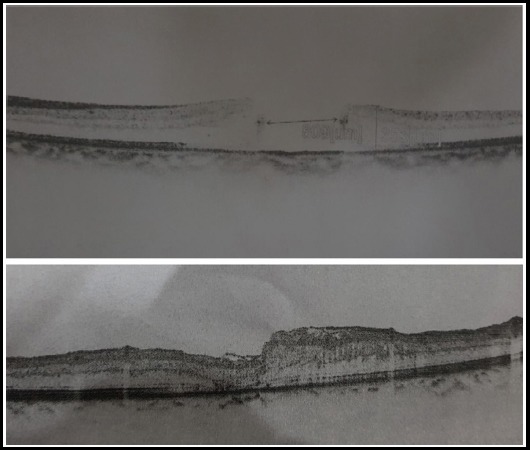
Shows pre-opertaive and post-operative OCTs of macular hole closure with inverted ILM flap.